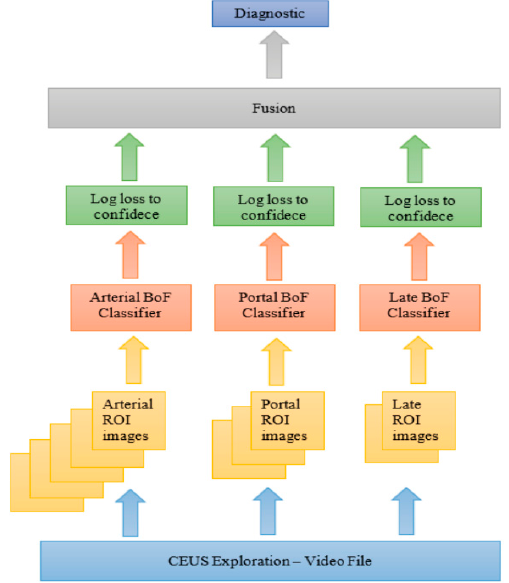
Figure 3. BoF based CAD system for CEUS FLLs diagnosis.